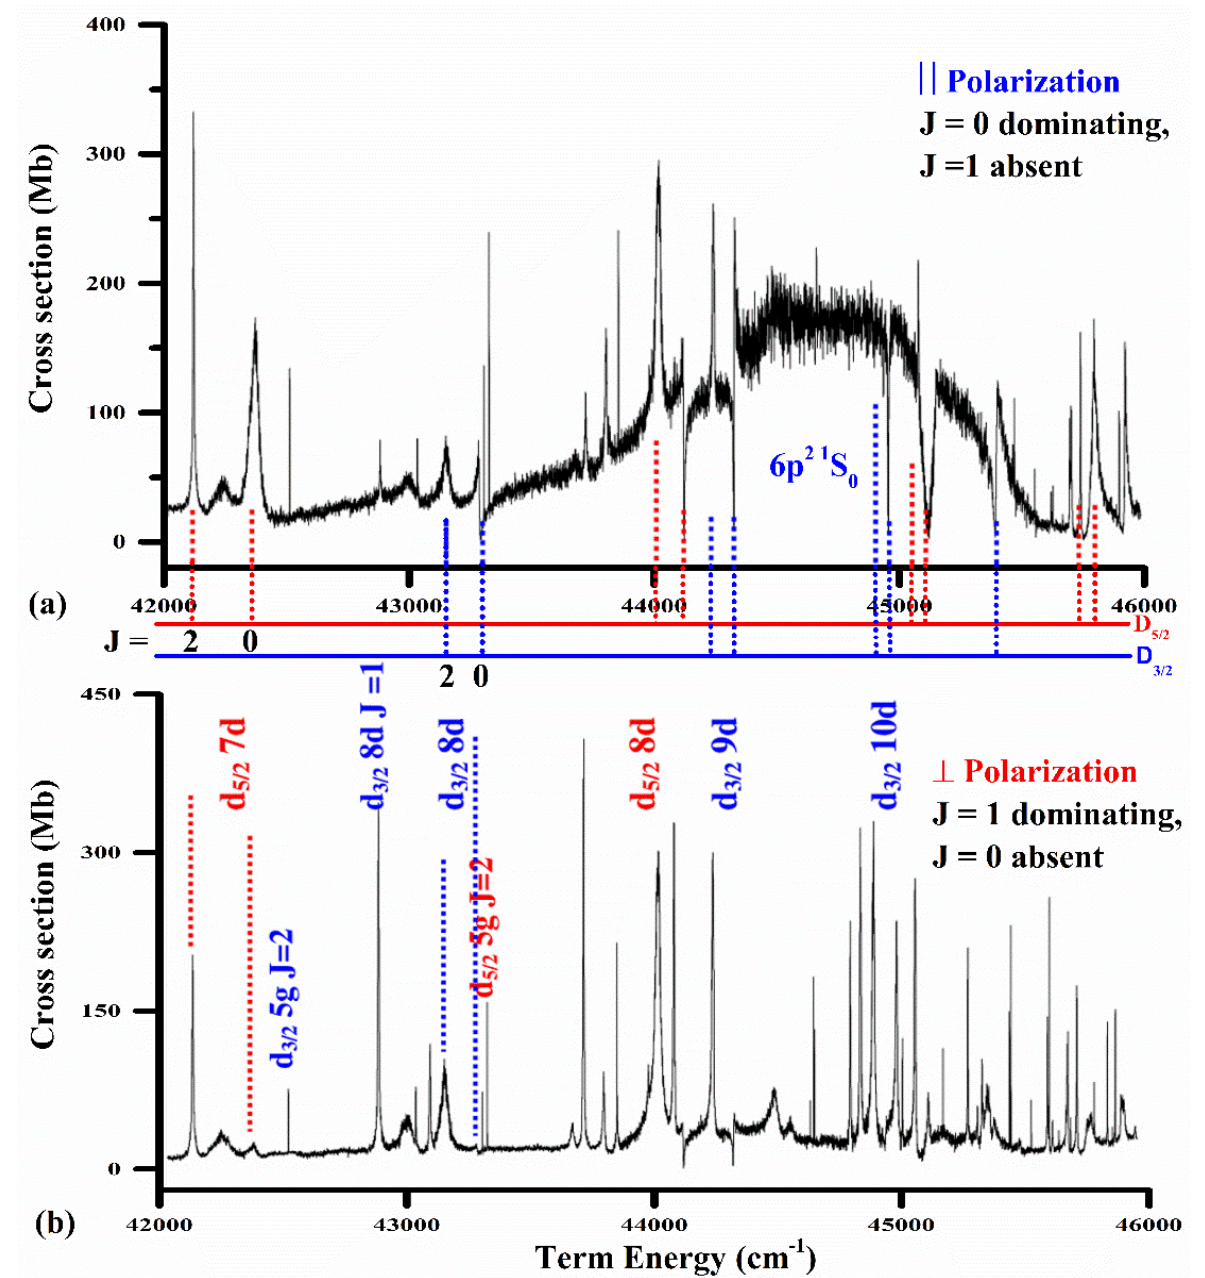
Figure 9. Photoionization spectra of barium excited from the 5d6p 1 P 1 intermediate level at polari- zation vectors of the ionizing laser either parallel ( a ) or perpendicular ( b ) to that of the exciting laser that enabled the assignment of the J-values of the excited levels unambiguously due to excitation selection rules.